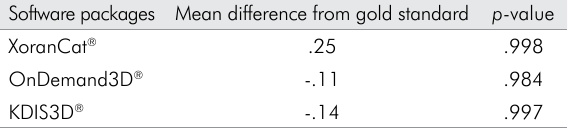
Table 2. Differences between the measurements (in mm) of the gold standard and those obtained by the three software